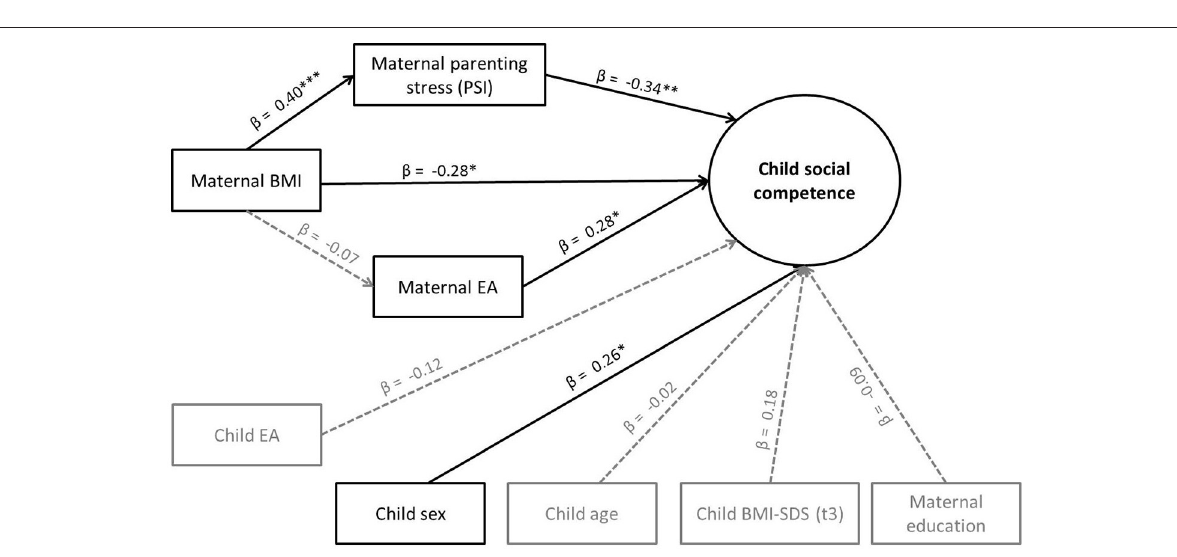
FIGURE 3 | Mediation effects (standardized regression coefficients β ) on children’s social competence (Model 3). * p < 0.05; ** p < 0.01; *** p < 0.001. Model fit: χ 2 (39 , N = 118) = 53.86, p = 0.06, and CFI = 0.92, RMSEA =